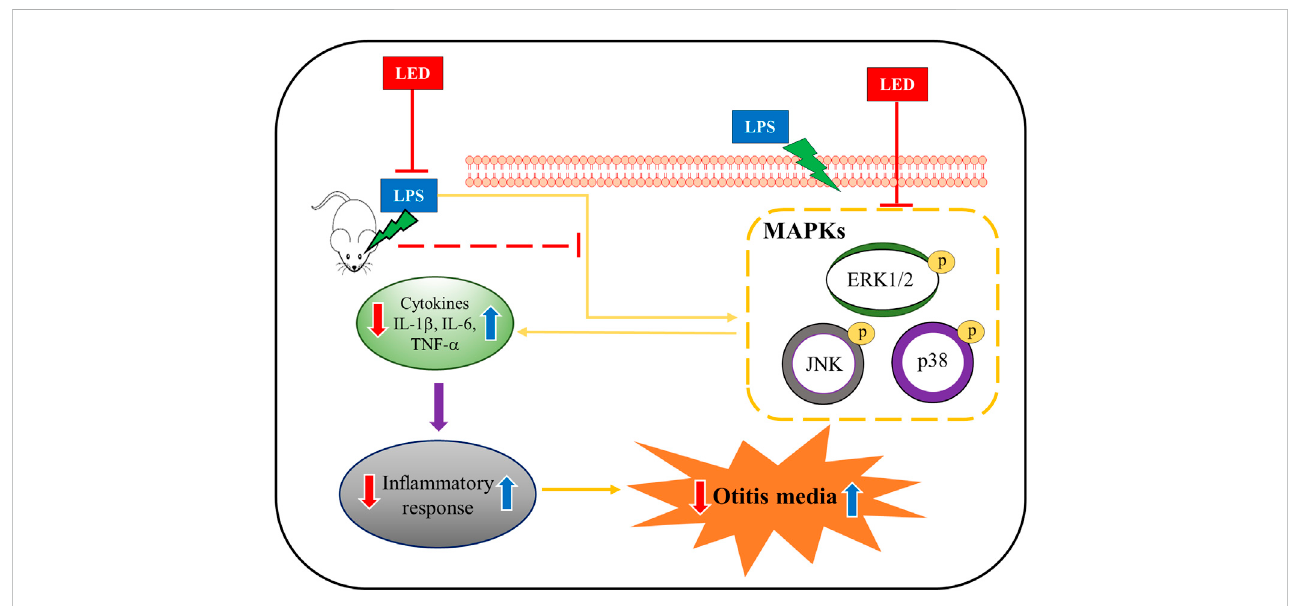
FIGURE 6 RepresentativeschematicofOMameliorationbyLEDirradiation.LEDreducedtheexpressionofpro-in fl ammatorycytokinesinducedbyLPSexposurein a rat model of OM, HMEECs, and RAW 264.7 cells via the inhibition of MAPK